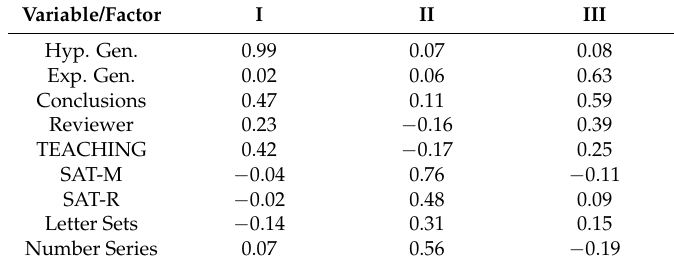
Table 6. Maximum-Likelihood Principal-Factor Analysis with Varimax-Rotated